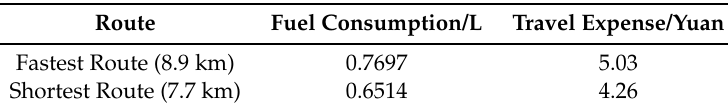
Table 2. Energy consumption of the gasoline